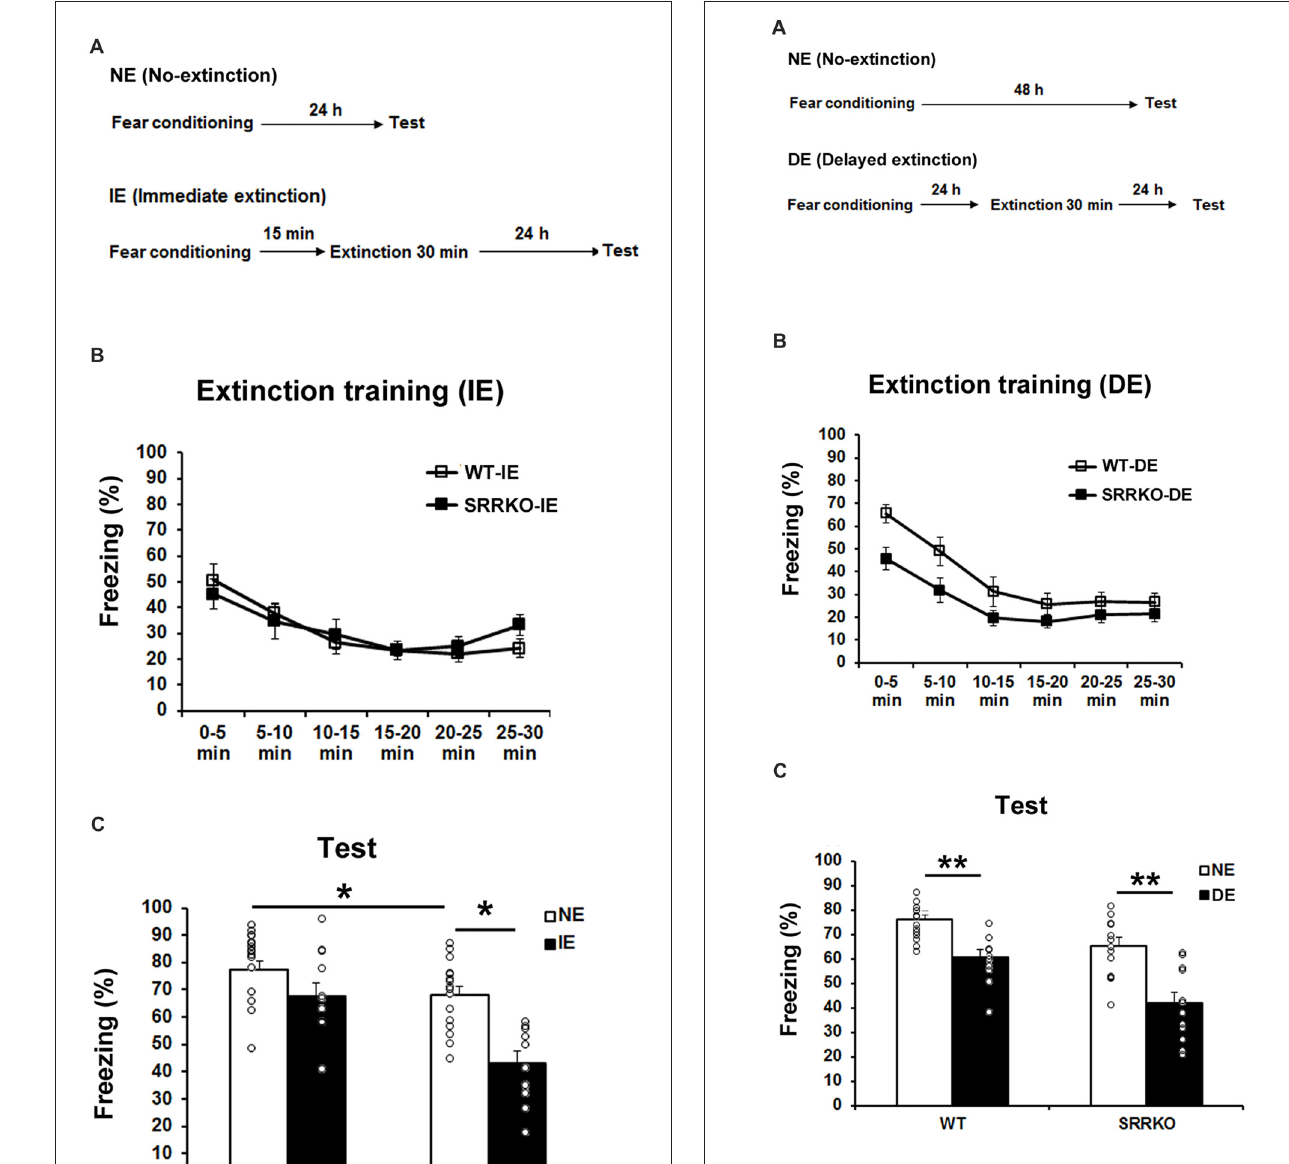
FIGURE 2 | Delayed extinction (DE) of contextual fear memory is comparable between WT and SRRKO mice. (A) Experimental schedule for contextual fear conditioning, DE and the recall test. (B) During the extinction training, SRRKO-DE ( n = 12) mice exhibited significantly lower levels of freezing than did WT-DE mice ( n = 10). However, there was no significant difference in within-session extinction between SRRKO-DE and WT-DE mice. (C) During the recall test, WT-DE and SRRKO-DE mice exhibited significantly lower levels of freezing than did WT-NE and SRRKO-NE mice, respectively (WT-NE, n = 13; SRRKO-NE, n = 13; ∗∗ p < 0.001). Data are presented as means ± SEM. was conducted 24 h after extinction training.